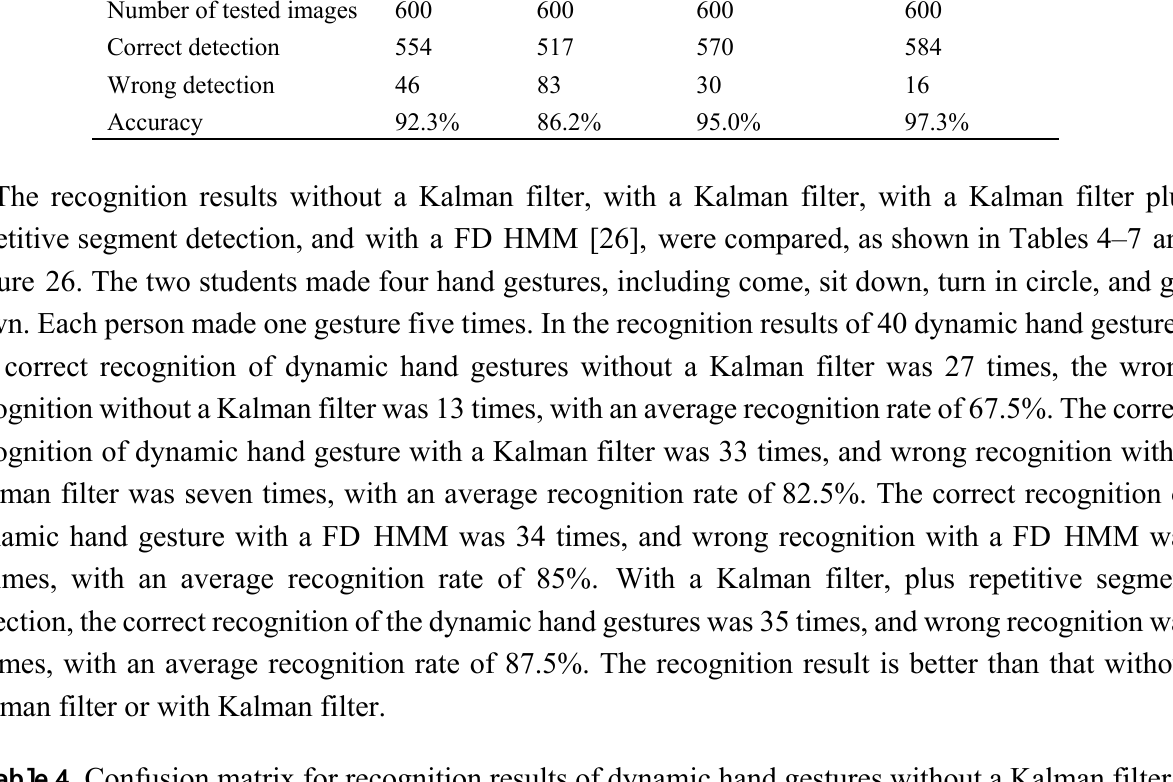
Table 4. Confusion matrix for recognition results of dynamic hand gestures without a Kalman filter.